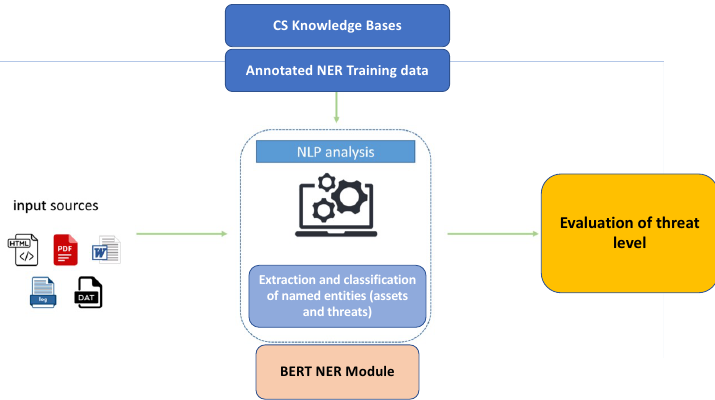
Figure 2. A conceptual schema of threat prioritization